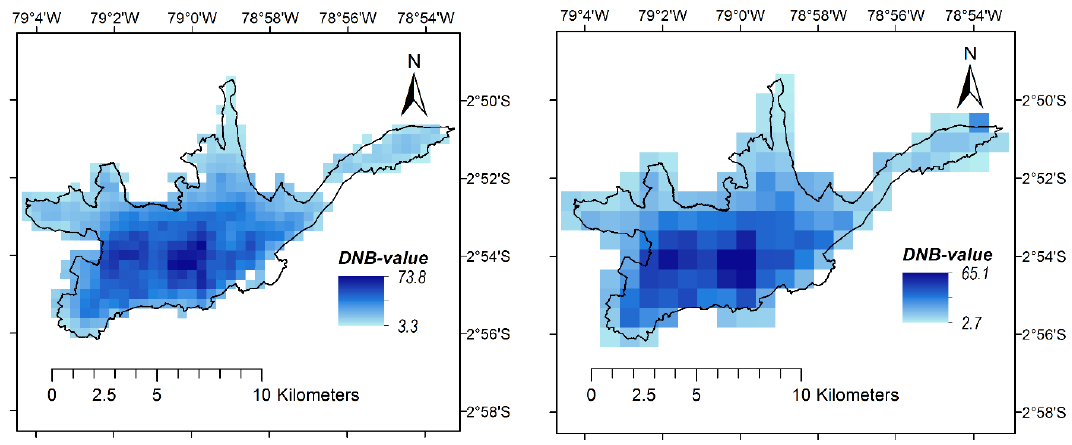
Figure 3. VIIRS Day/Night Band (DNB) data for Cuenca City. 15 arc-sec grid ( left ). Aggregated 30 arc-sec grid ( right ).